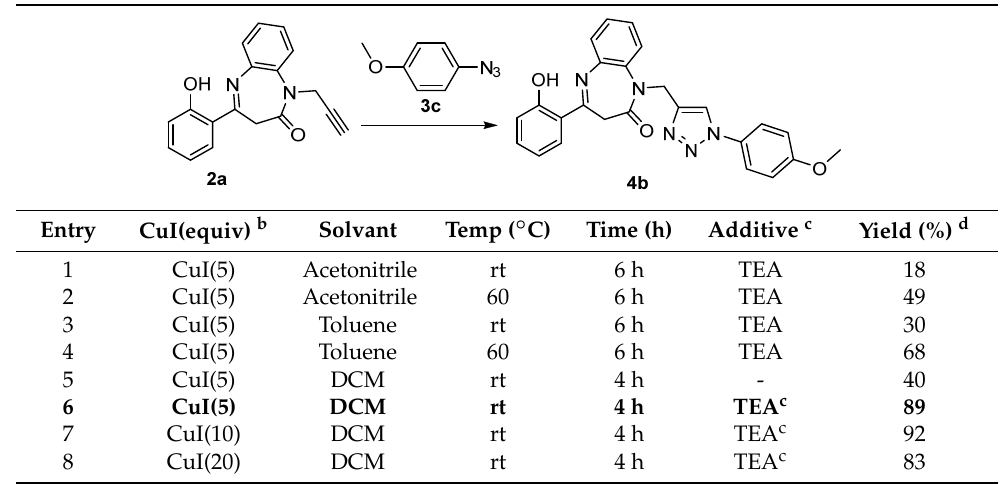
Table 1. Optimization of Cu(I)-catalyzed 1,3-dipolar cyclization for the synthesis of 1,2,3-triazoles 4a – i a .